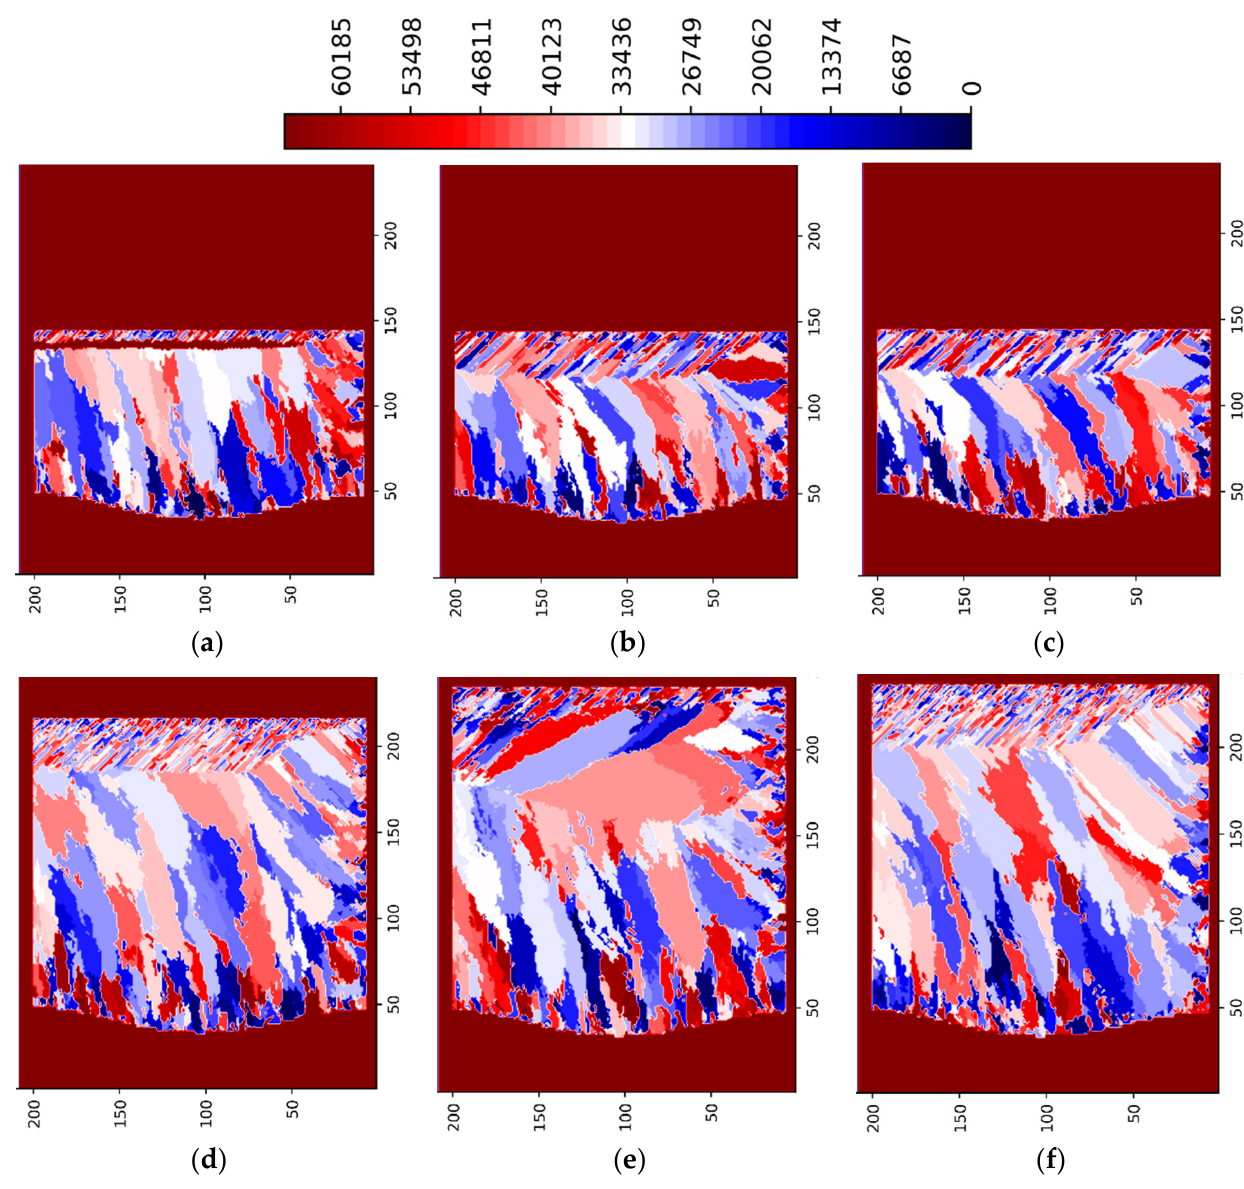
Figure 5. LPBF IN718 simulated grain structure (3 layers, 5 tracks)—ZY plane (P = 250 W) ( a ) layer 1